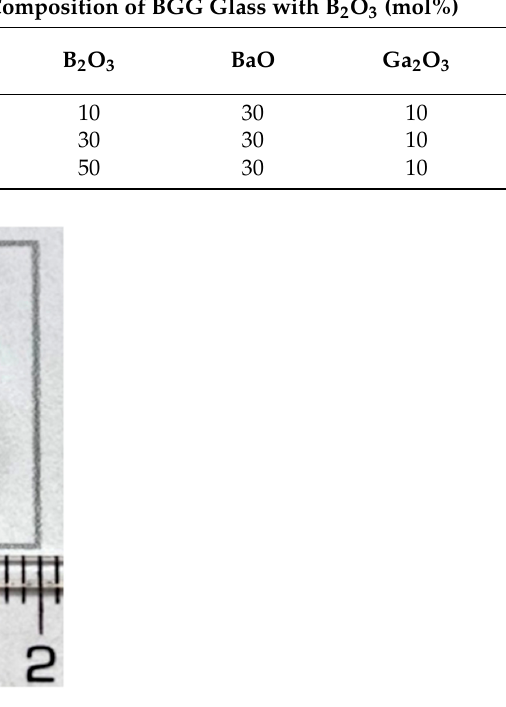
Figure 1. Photographs of the obtained glass sample: 30GeO 2 ‐ 30TiO 2 ‐ 30BaO ‐ 10Ga 2 O 3 (GT2).